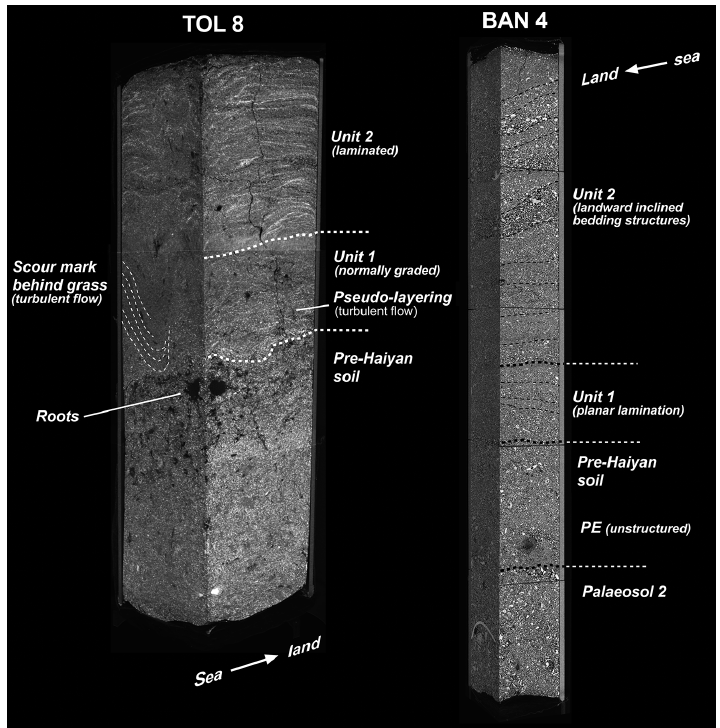
Figure 7. µCT scans of sediment cores TOL 8 and BAN 4 (as for locations see Figs. 5d and 10f respectively). The 3-D data support the documentation and interpretation of sedimentary features and different units within the typhoon deposits. The basal unit of TOL 8 is slightly normally graded and characterized by scour structures behind bent grass stems (unit 1). The upper part is horizontally laminated (unit 2). In BAN 4 the deposit of Typhoon Haiyan clearly contrasts the unstructured pre-Haiyan sediments composed of two palaeosols separated by an older sand sheet. It is divided into a planar bedded unit 1 at the base and steeply landward-inclined laminae in unit